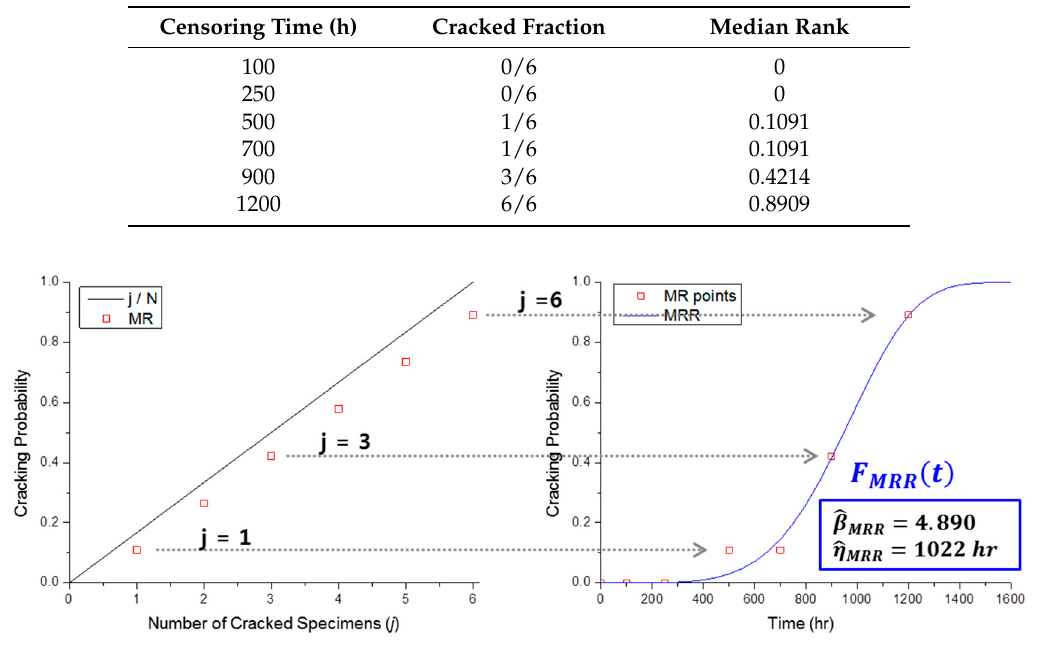
Figure 2. Example of Weibull estimation by MRR with the test data from Table 1.